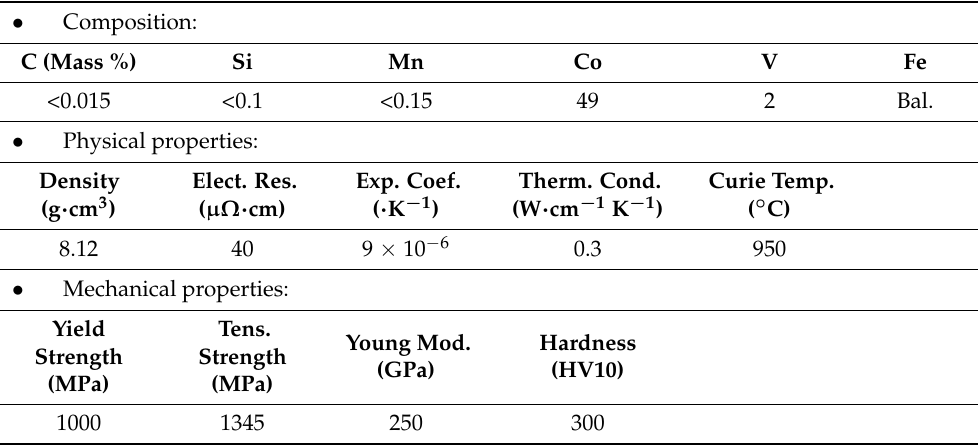
Table 1. Composition, physical and mechanical properties of the tested specimens.